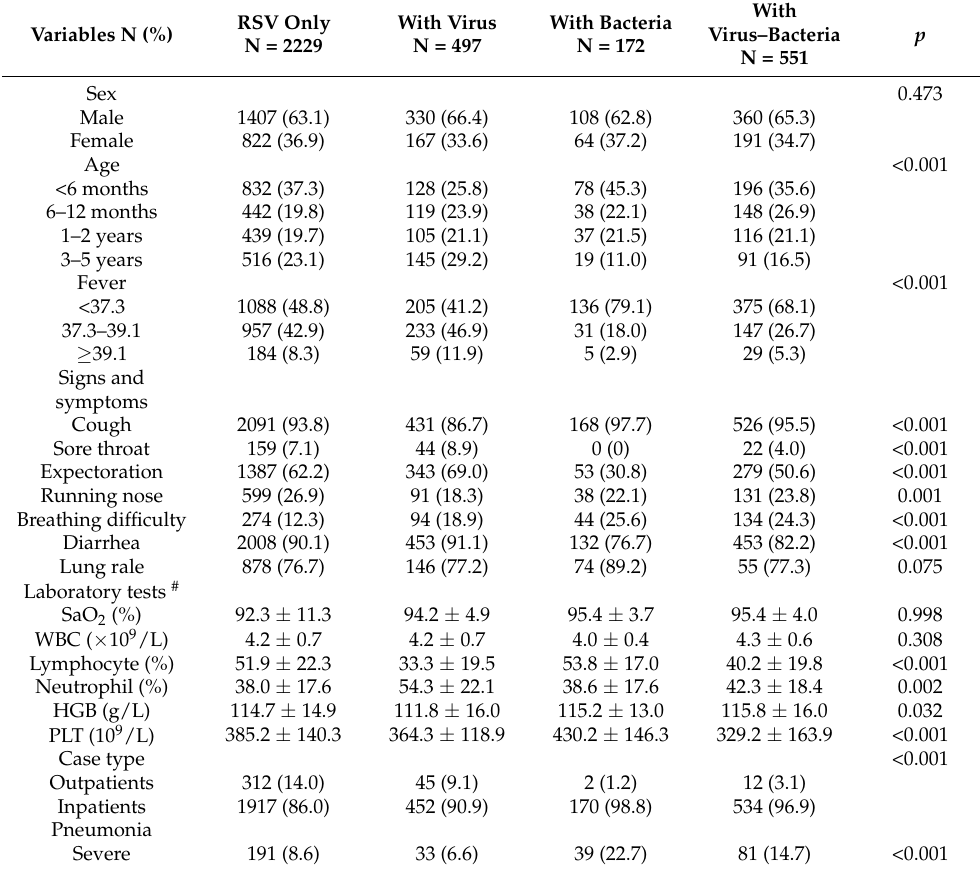
Table 4. Clinical characteristics of patients in whom RSV was co-detected with other common respiratory viruses and bacteria. Variables N (%)